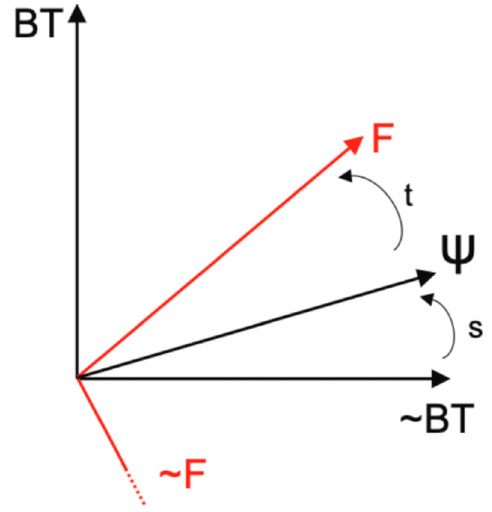
Figure 1. A caricature representation of a quantum model based on one-dimensional projectors, on a two-dimensional space.